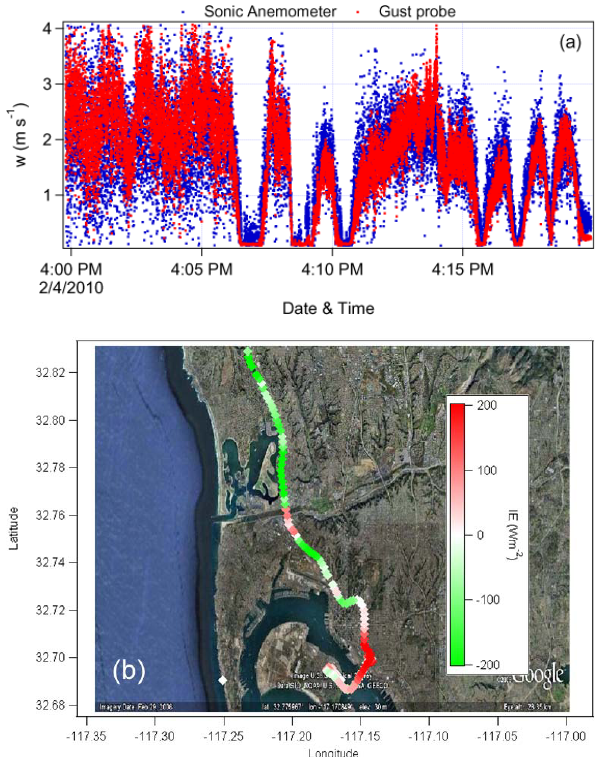
Fig. 3. Vehicular test results indicating (a) time series plots of sonic anemometer and gust probe vertical wind, and (b) calculated fluxes along truck measurement